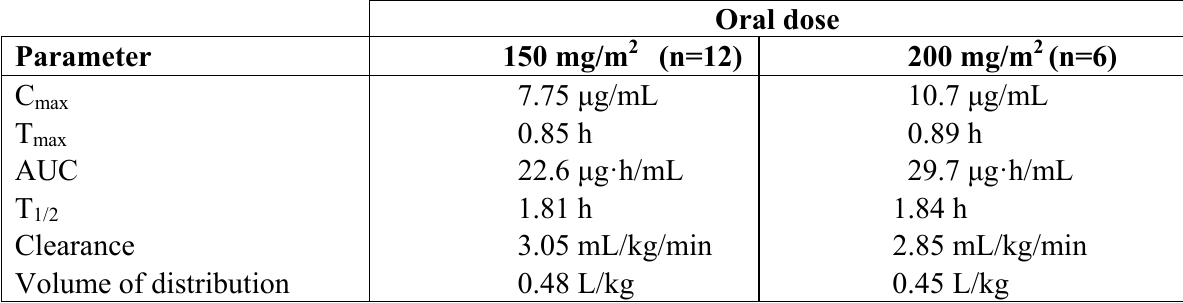
Table 1 . Pharmacokinetics after single dose of temozolomide